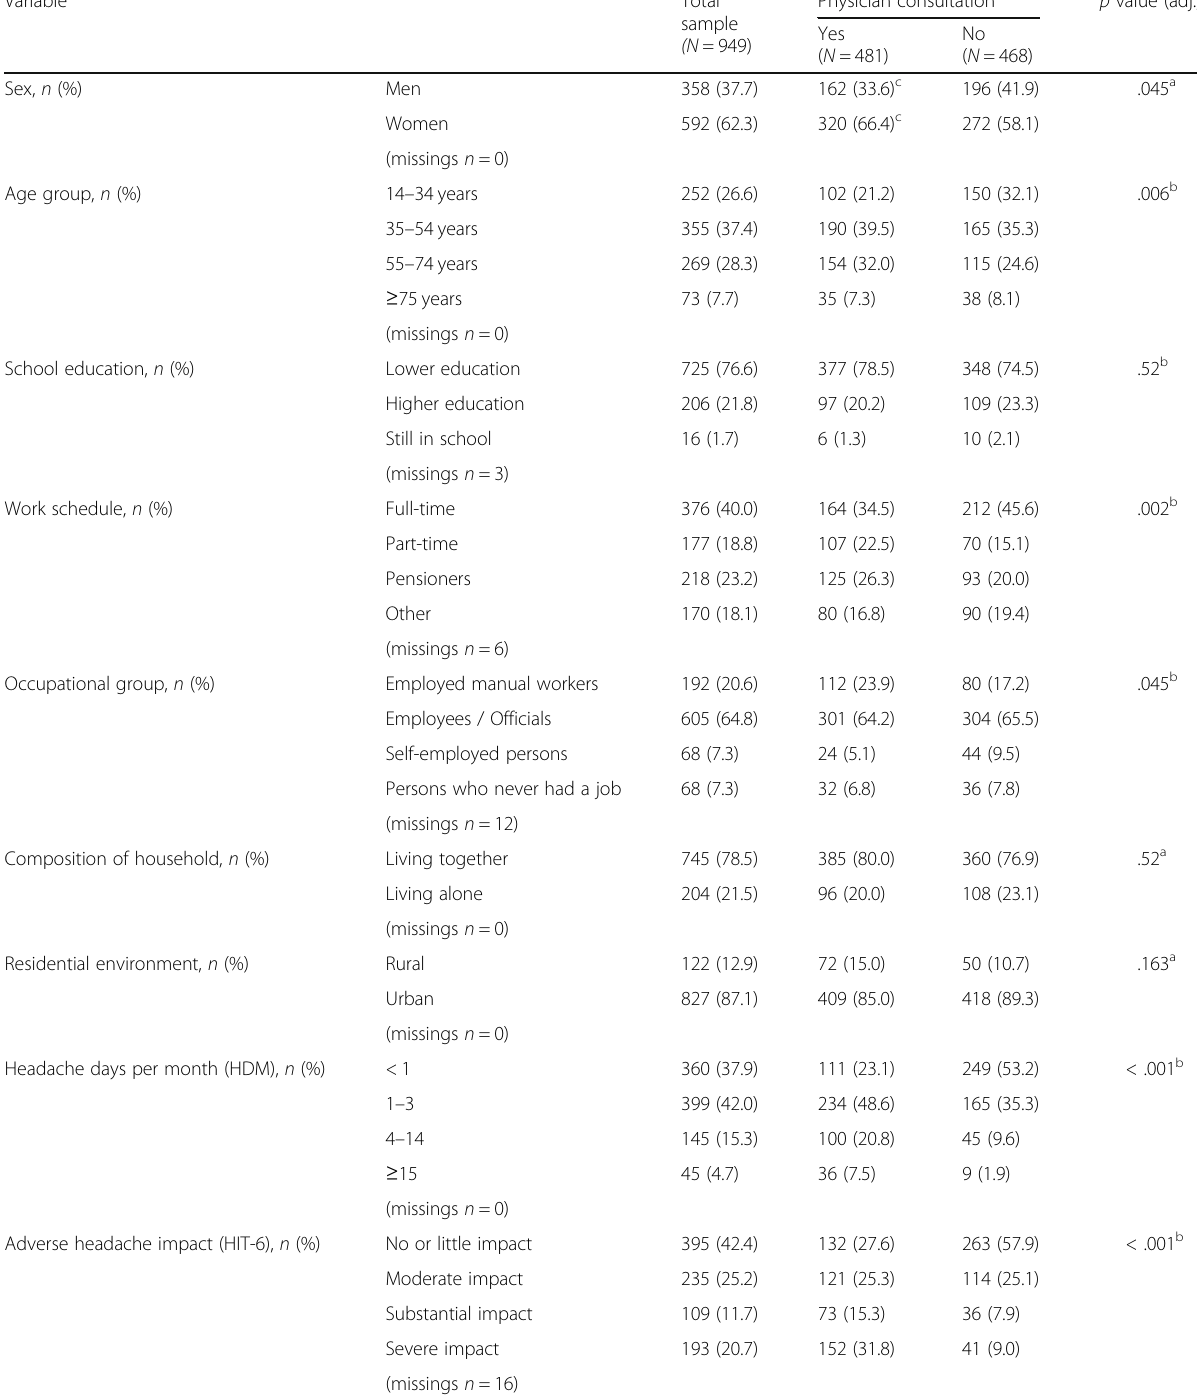
Table 1 Sociodemographic and health-related characteristics of the study sample